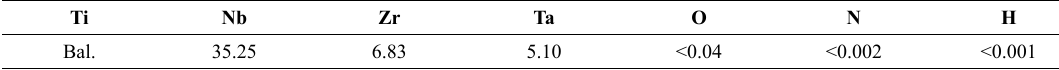
Table 1. Chemical composition of the as-received Ti alloy (wt%).